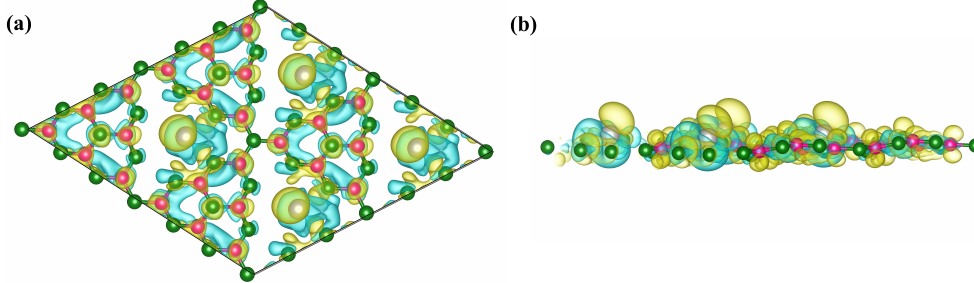
Figure 5. Charge density difference for the Al-decorated g-C regions indicate charge gain and the blue regions indicates charge loss. The isosurface of charge density is 0.003 e/Bohr 3 .